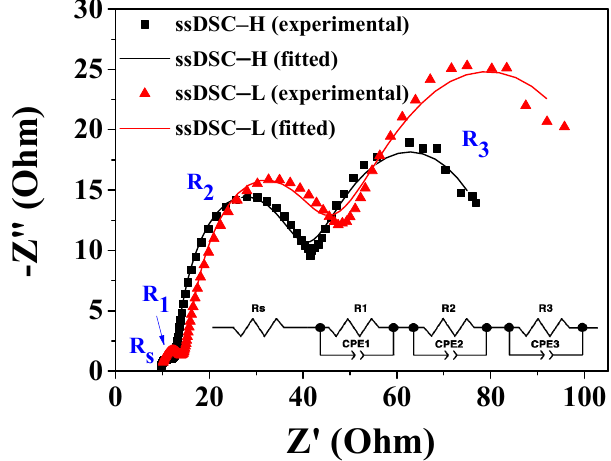
Figure 7. J – V characteristics of the additive-containing hole-only devices.